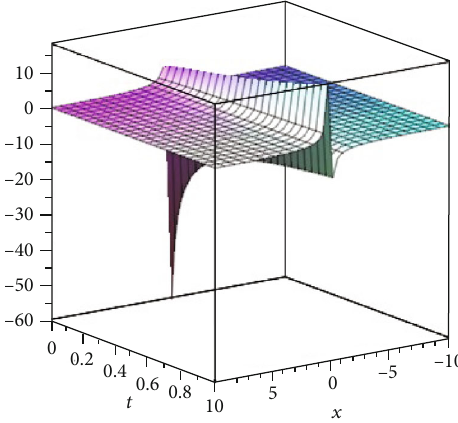
ð x , t Þ of Equation (45). Figure 7: u 1,1